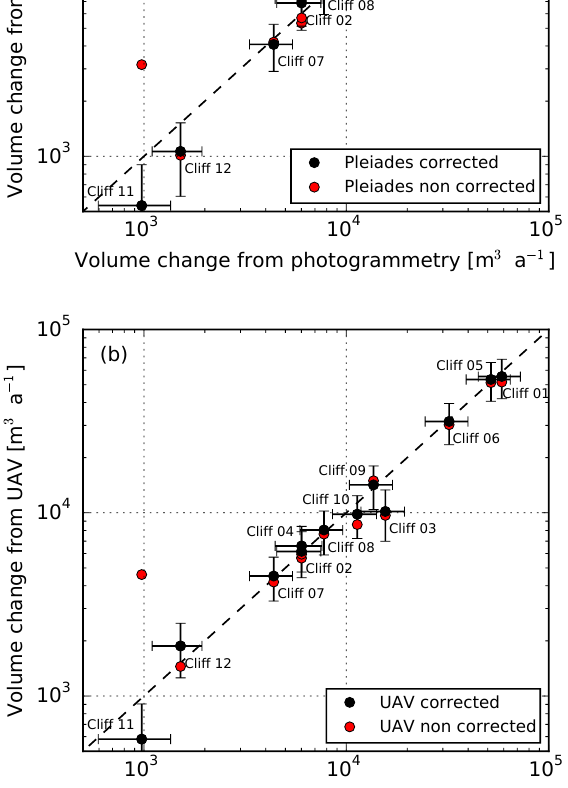
Figure 7. Comparison of the ice cliff volume changes esti- mated from DEM differences between Pléiades (a) or UAV (b) and terrestrial photogrammetry for the period November 2015– November 2016. Note the log-scale. For each panel, “corrected” means taking into account the geometric corrections due to glacier flow and “non-corrected” means neglecting